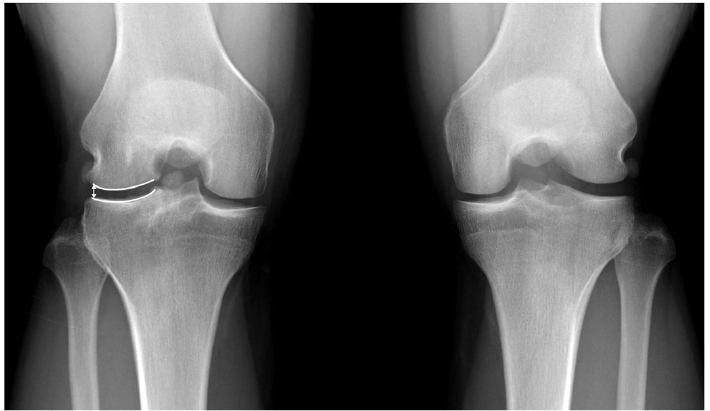
Figure 5. The absolute joint space width is measured from the lateral edge of the femoral condyle to the lateral edge of the tibial plateau (white arrow).